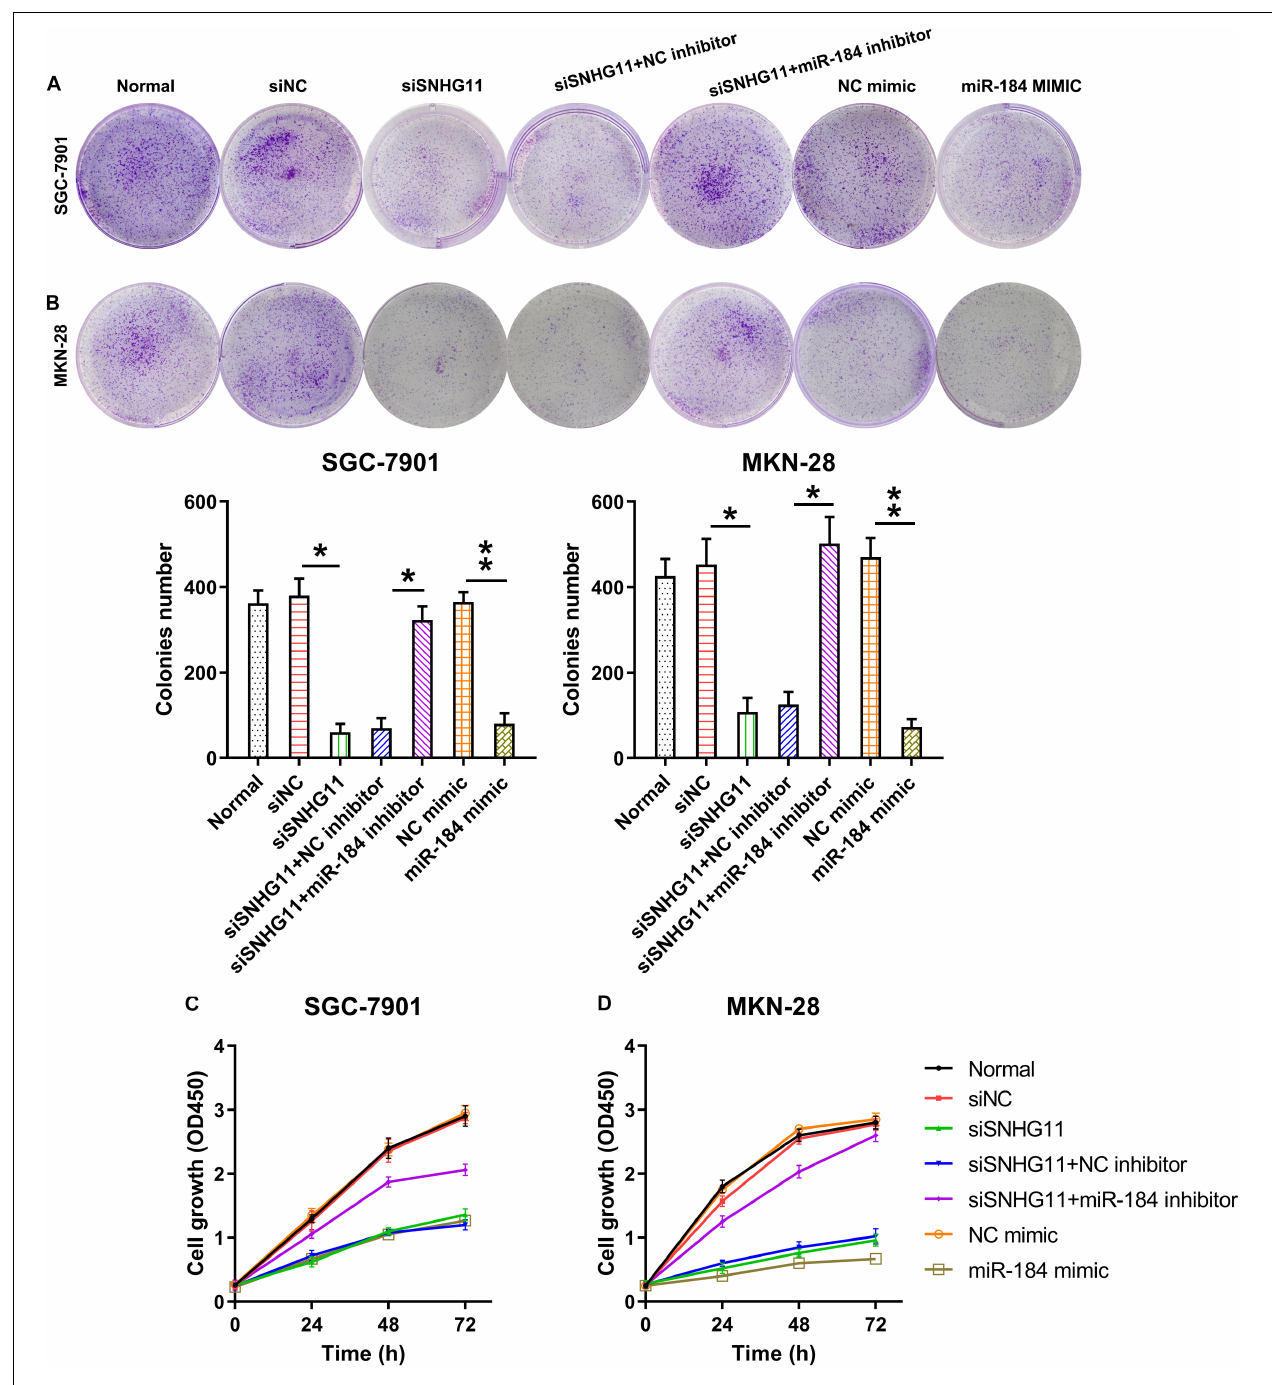
FIGURE 4 | The part of SNHG11 and miR-184 in MKN-28 and SGC-7901cells’ growth and proliferation. MKN-28 and SGC-7901 cells were subjected to NC shRNA, SNHG11 shRNA, SNHG11 shRNA + NC inhibitor, SNHG11 shRNA + miR-184 inhibitor, NC mimic, and miR-184 mimic for 36 h, or not. (A,B) Soft agar colony generation assay for cells at 96 h after transfection. (C,D) CCK-8 assay demonstrated cell proliferation at 1, 2, and 3 days after transfection. “Normal” represents non-transfected cells. These data are shown as average ± SD . * P < 0.05, ** P < 0.01 vs. indicated